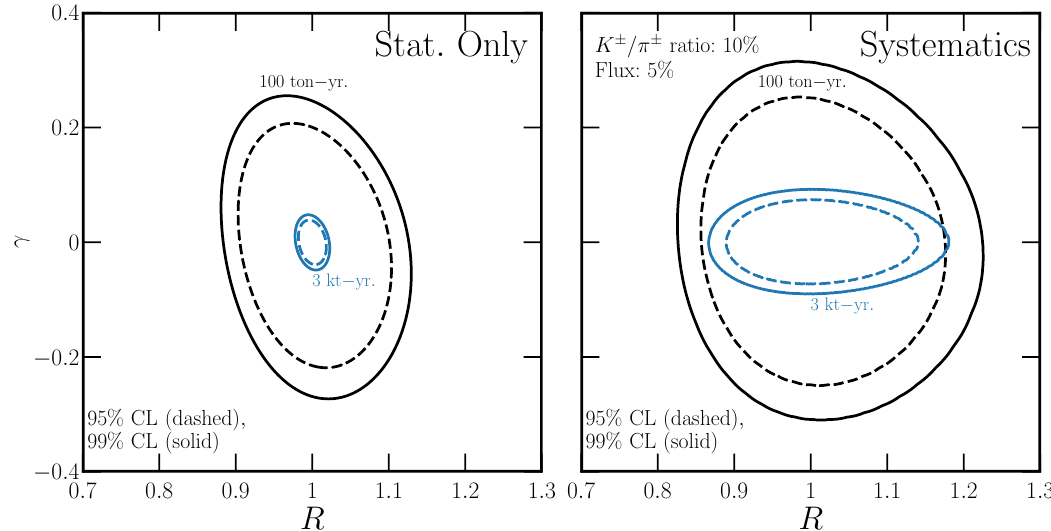
Figure 7. Measurement capability of LEvEL for 100 ton-year (black) or 3 kton-year (blue) to measure the ν e Ar cross section. We parameterize the cross section as given in eq. (4.1) with an overall normalization R and a spectral tilt γ . Dashed (solid) curves correspond to 95% (99%) CL contours. The left panel assumes a statistics-only measurement, where the right panel assumes a 5% correlated normalization uncertainty along with a 10% uncertainty on the production ratio between charged kaons and pions. Statistics Only With Systematics